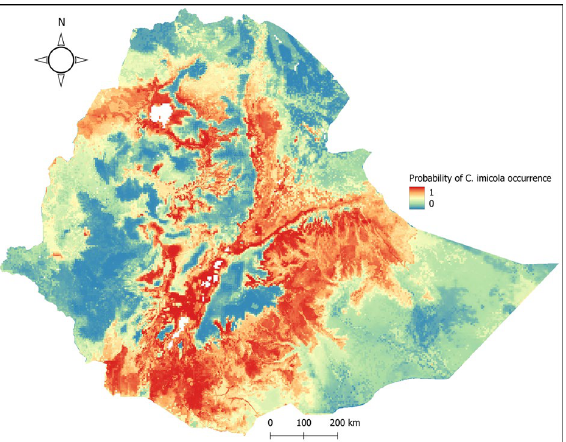
Figure 2. Probability of C. imicola occurrence in Ethiopia. Highly suitable areas are represented with red color while unsuitable areas are represented using blue colour. The map was created using QGIS software v 3.22.2 (https:// qgis. org/).